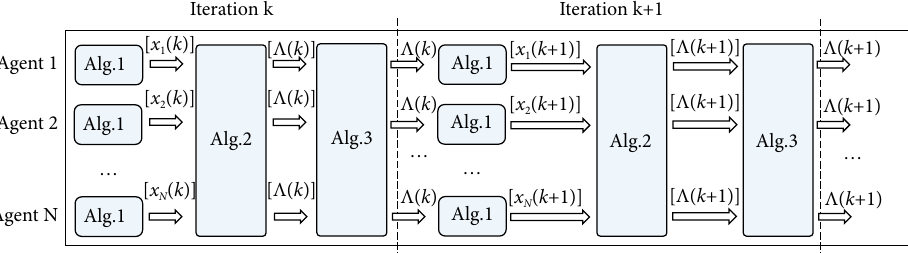
Fig. 5 Comparison on traditional hierarchical D&C framework and SMPC-based distributed optimization framework.